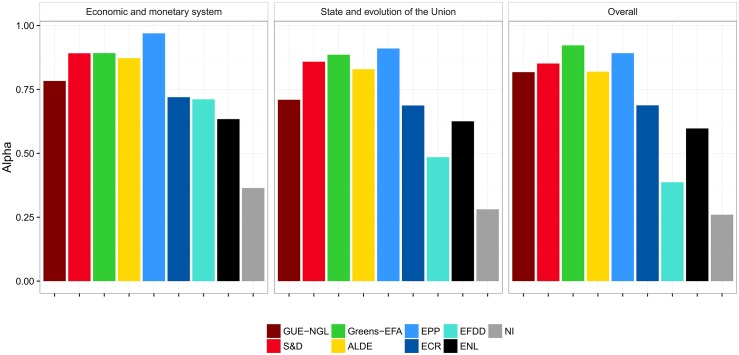
Cohesion of political groups in terms of RCVs as measured by Krippendorff’s Alpha.There are two selected policy areas (the left-hand panels), and overall cohesion across all policy areas (the right-hand panel). The Alpha-agreement of 1 indicates perfect co-voting agreement, and 0 indicates co-voting by chance. The overall average Alpha across all nine political groups is 0.7.